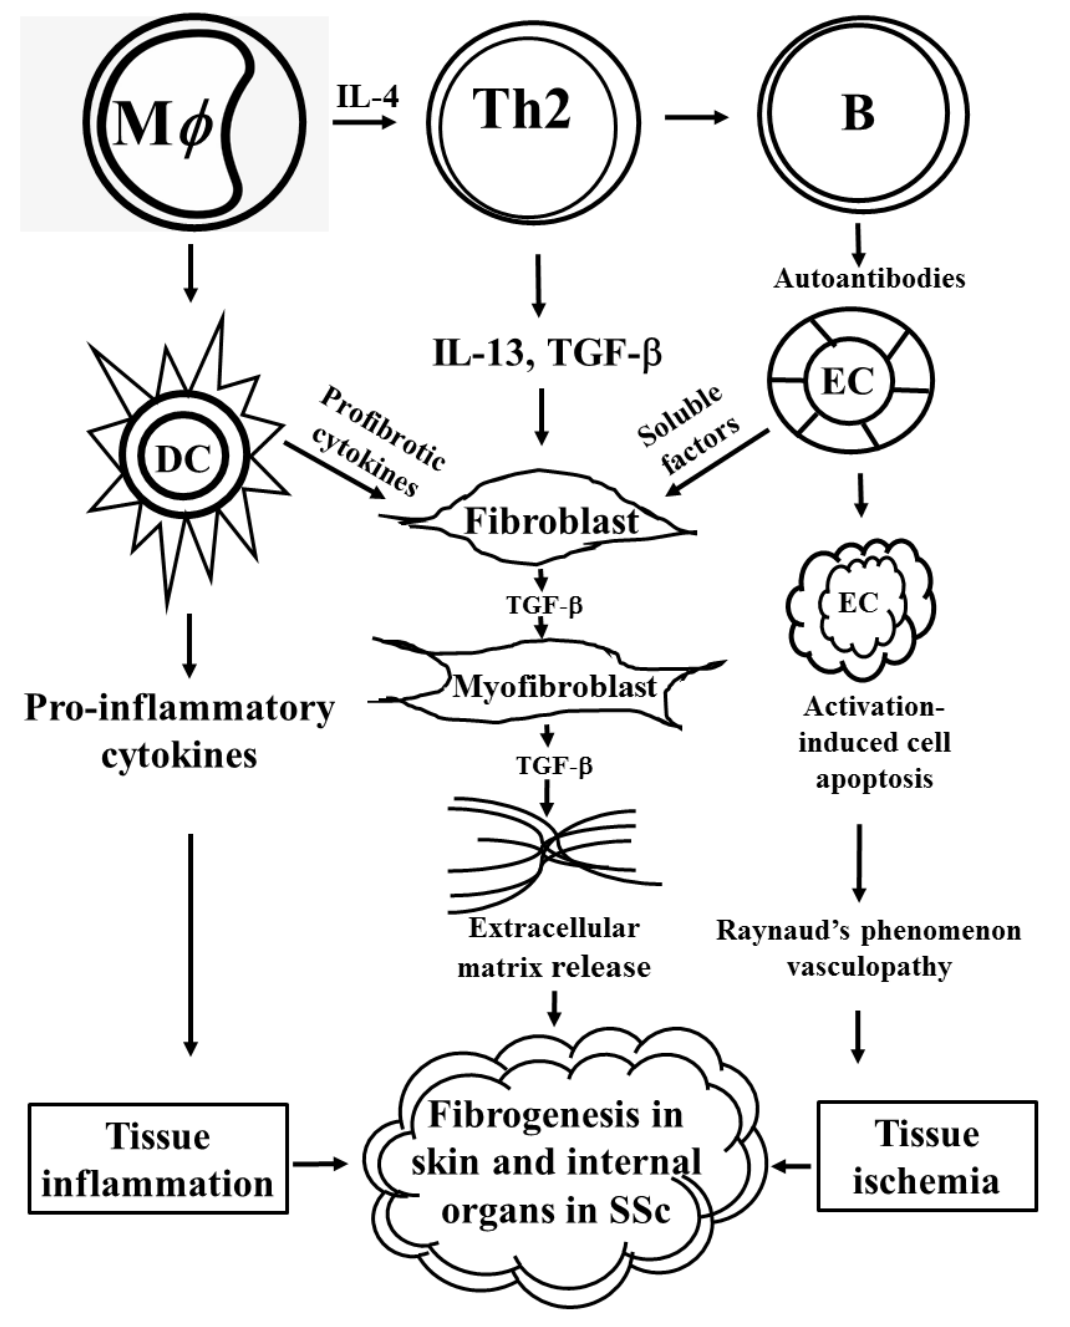
Figure 1. Autoimmune-mediated fibroblast-to-myofibroblast trans-differentiation, vascular endothelial cell (EC) damage, tissue ischemia, tissue inflammation, and finally tissue fibrosis in patients with systemic sclerosis. Table 1. Autoantibody-related clinical manifestations in patients with systemic sclerosis (SSc).